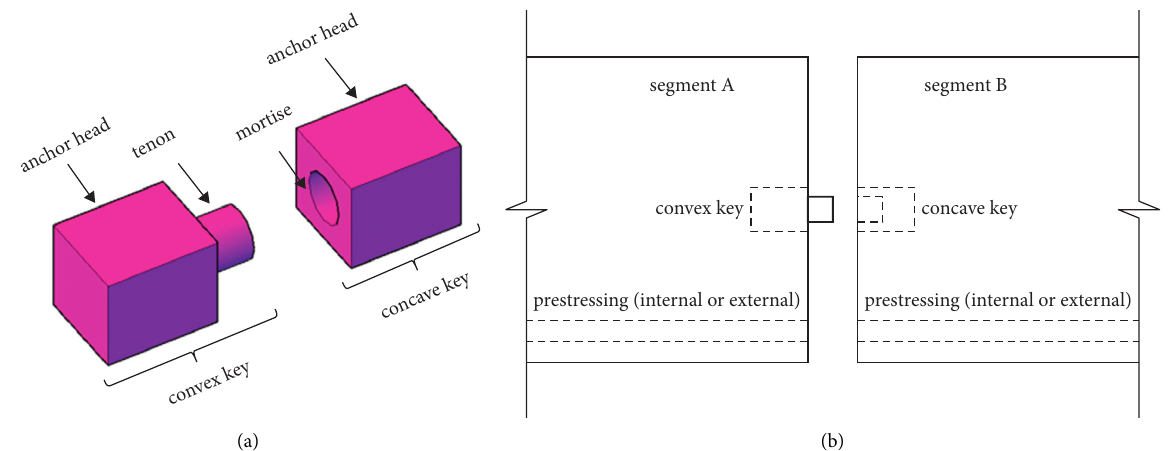
Figure 1: Schematic diagram of steel shear keyed joint. (a) Steel shear key and (b)